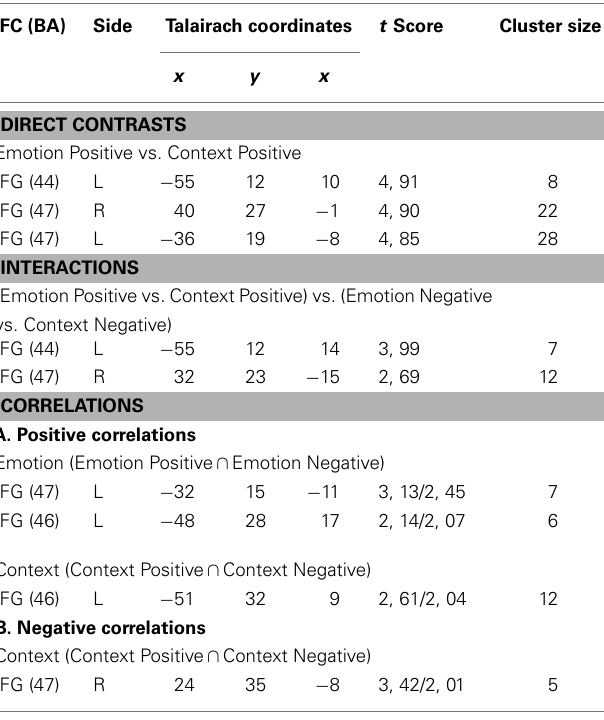
Table 1 | Significant activations and correlations linked to the retrieval focus and the emotional valence of memories